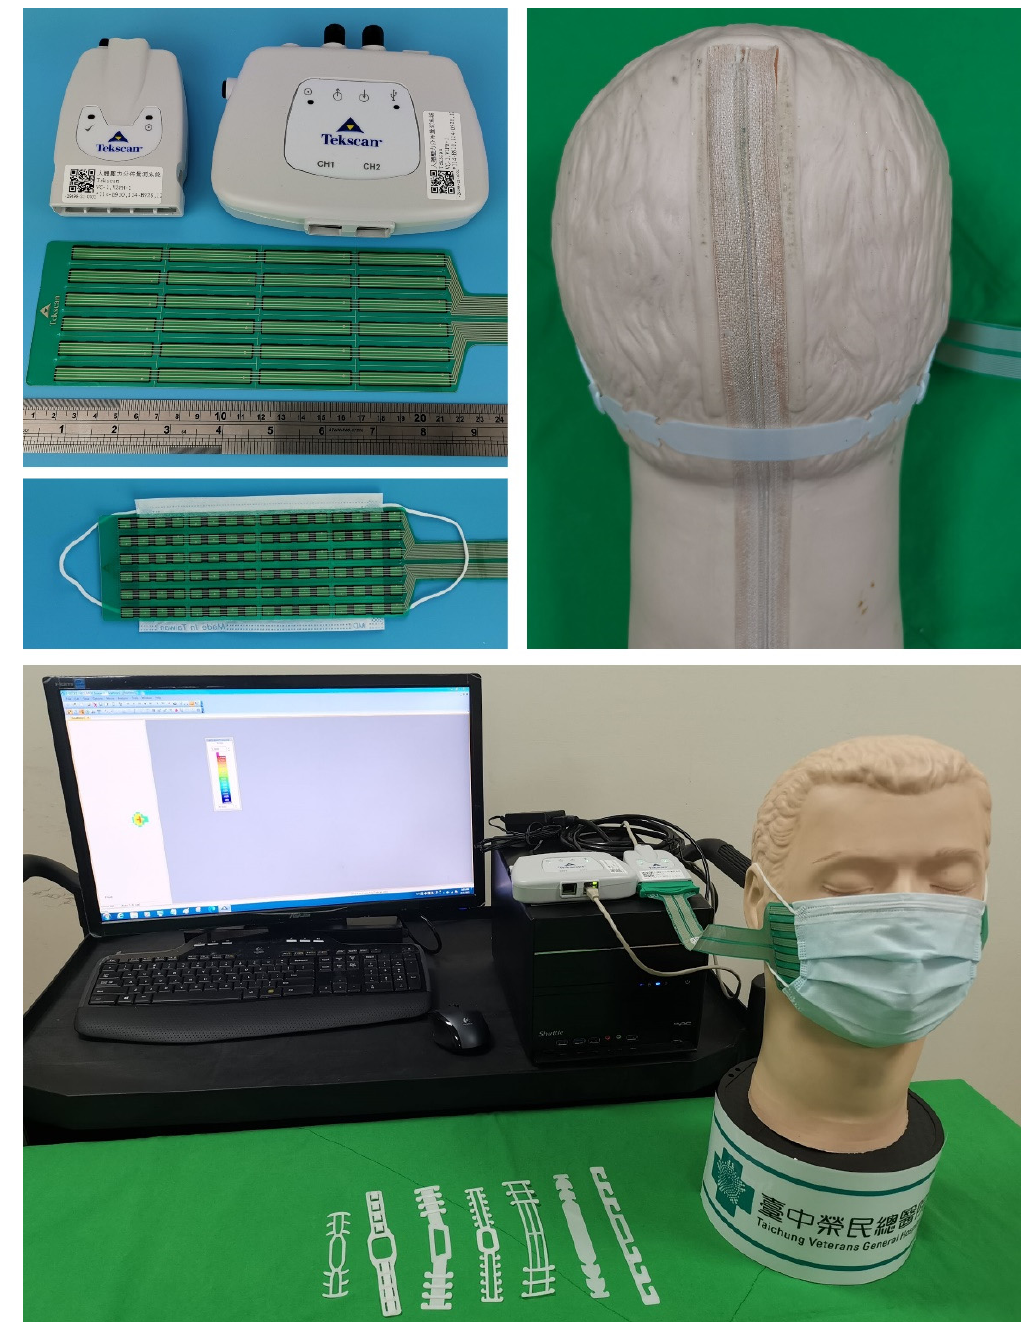
Figure 4. A mask was put on the dummy’s head with the sensor array measuring the pressure dis- tribution on its face while using an